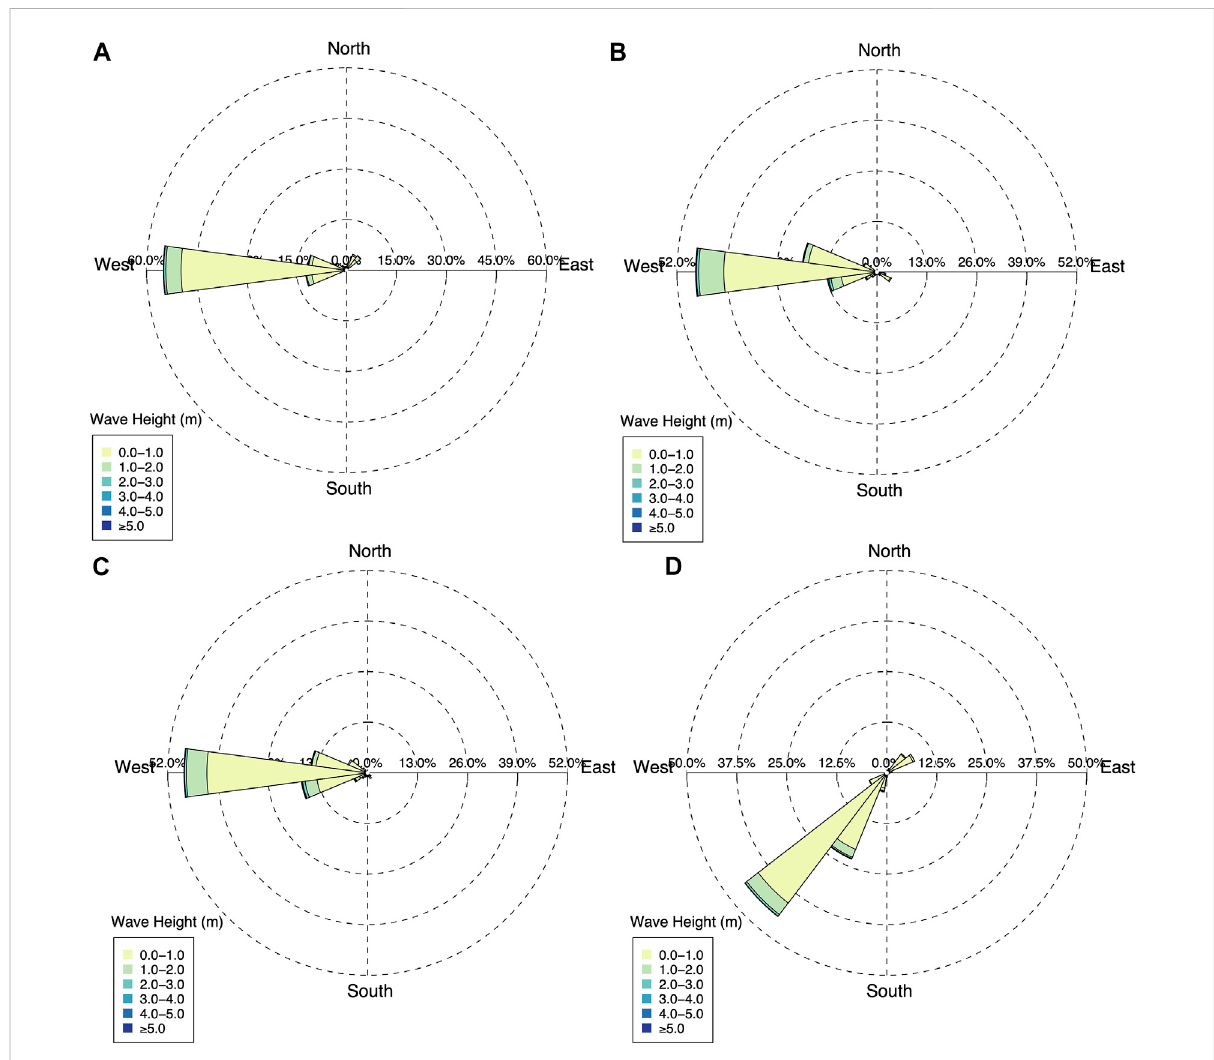
FIGURE 12 Rose plots of signi fi cant wave height distribution over wave incoming direction, for sites CY-1 (A) , CY-2 (B) , CY-3 (C) , CY-4 (D) , of Figure